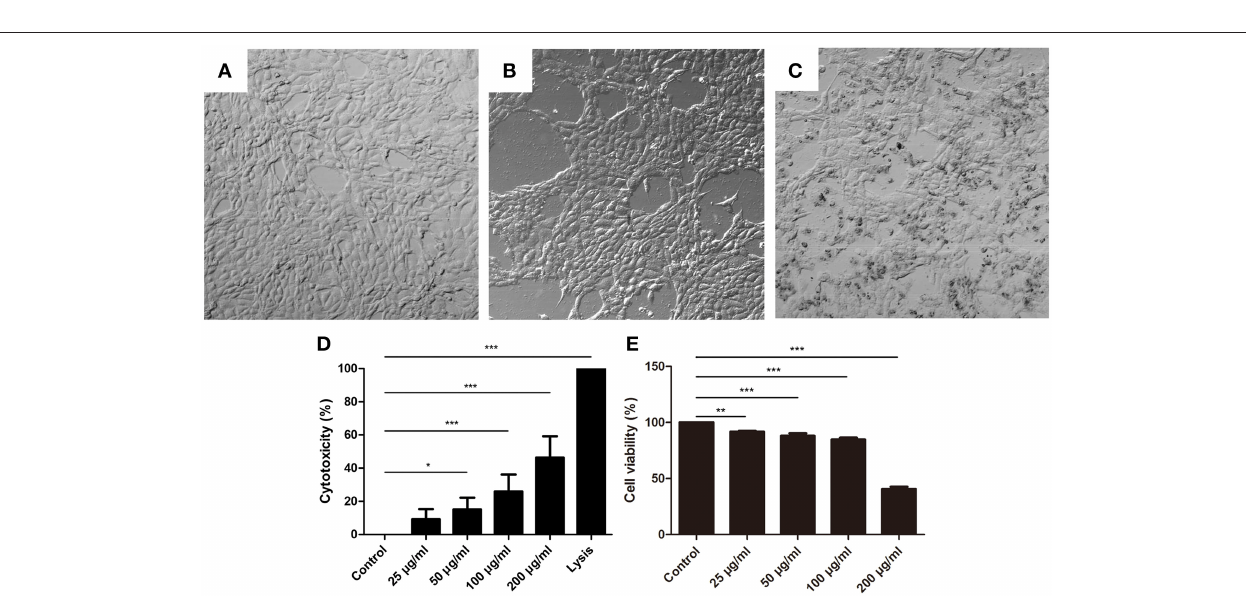
FIGURE 3 | Histone caused BMECs death. (A–C) The changes of BMECs morphology were measured after treatment with different concentrations of histone for 16h (400 × ). Three independent experiments were carried out by light microscope analyses. (A) Controls. (B) BMECs treated with histone (100 µ g/mL). (C) BMECs treated with histone (200 µ g/mL). (D) Histone induced cytotoxicity to BMECs. The cytotoxicity of BMECs was determined by LDH Cytotoxicity Assay Kits after treatment with different concentrations for 16h. Lysis provided by LDH Cytotoxicity Assay Kits was used as positive controls. (E) Effects of histone on the viability of BMECs. BMECs were incubated with histone and examined by CCK-8 kits. Date are presented as mean ± SEM ( n = 5). P < 0.05 were considered significant (* P < 0.05, ** P < 0.01, and *** P < 0.001).